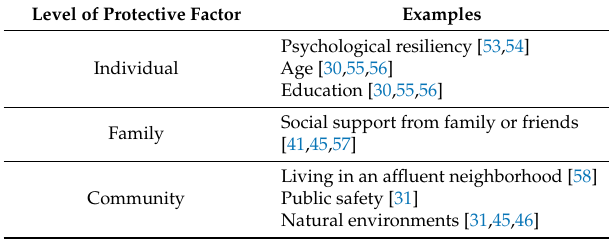
Protective factors that facilitate resilience, occurring at the individual, family, and community